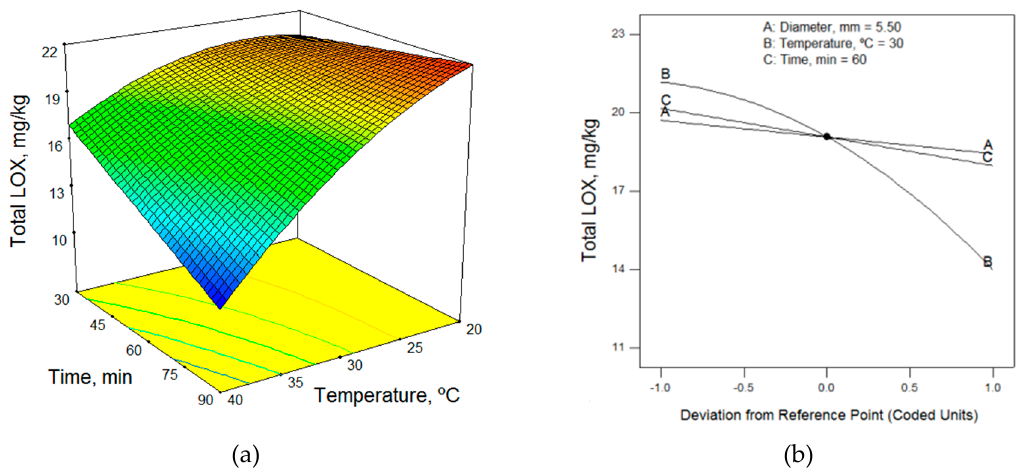
Figure 3. ( a ) Response surface and ( b ) perturbation graphic of the effects of temperature and time on the total LOX volatile content for the Arbosana cultivar (irrigated, MI = 0.07), for a diameter of 5.5 mm.